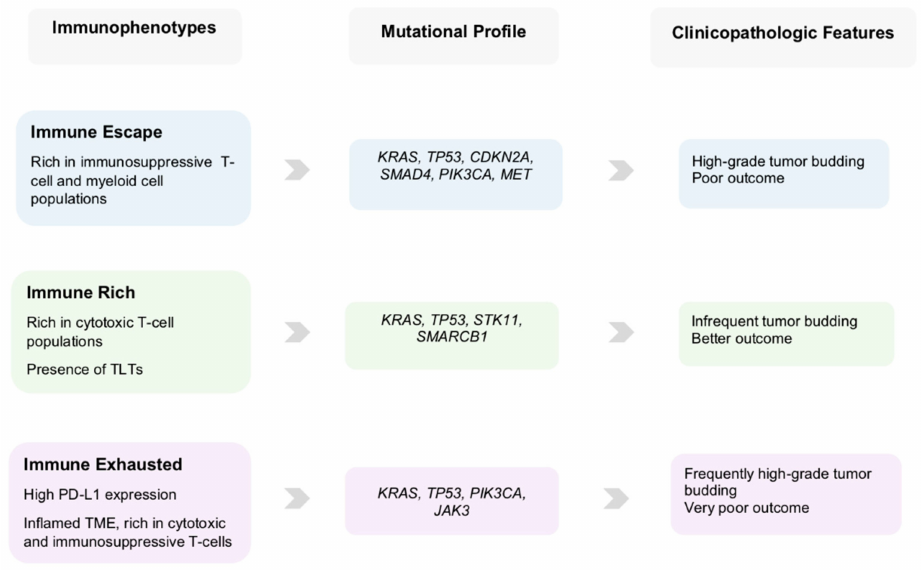
Figure 3. Table summarizing the immune, genetic and clinicomorphologic findings of the three immunophenotypes of pancreatic